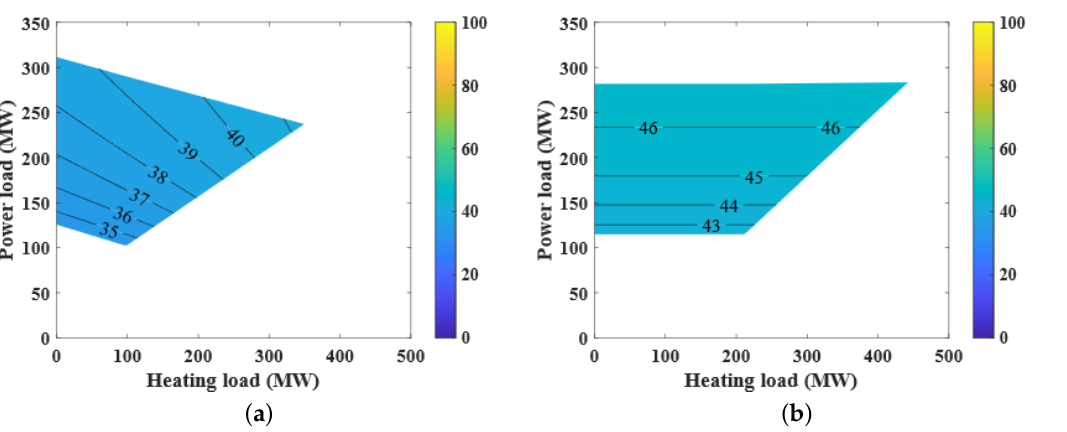
Figure 13. η ex in the feasible operational region: ( a ) EC system; ( b ) HBP e , CHP